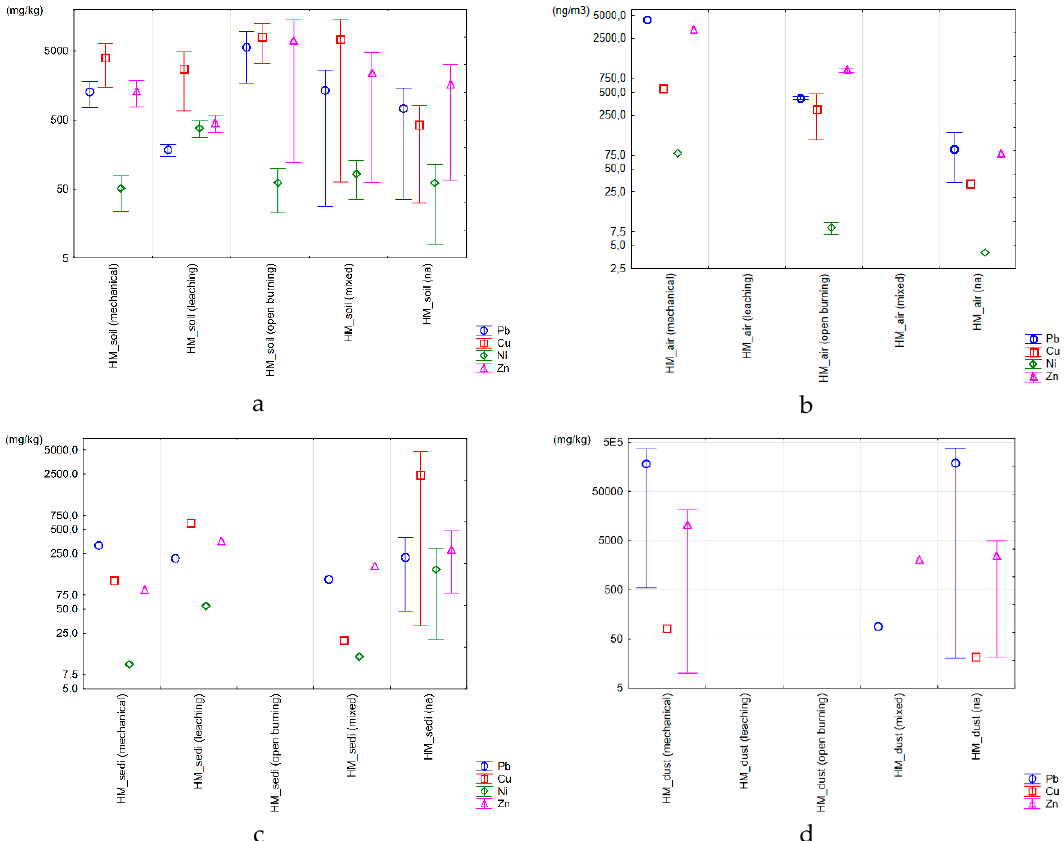
Figure 4. Range plot of heavy metal variables with the minimum, mid-point, and maximum values for the soils ( a ), air ( b ), sediment ( c ), and dust samples ( d ) according with the treatment processes (mechanical, leaching, open burning, mixed, na: not available).